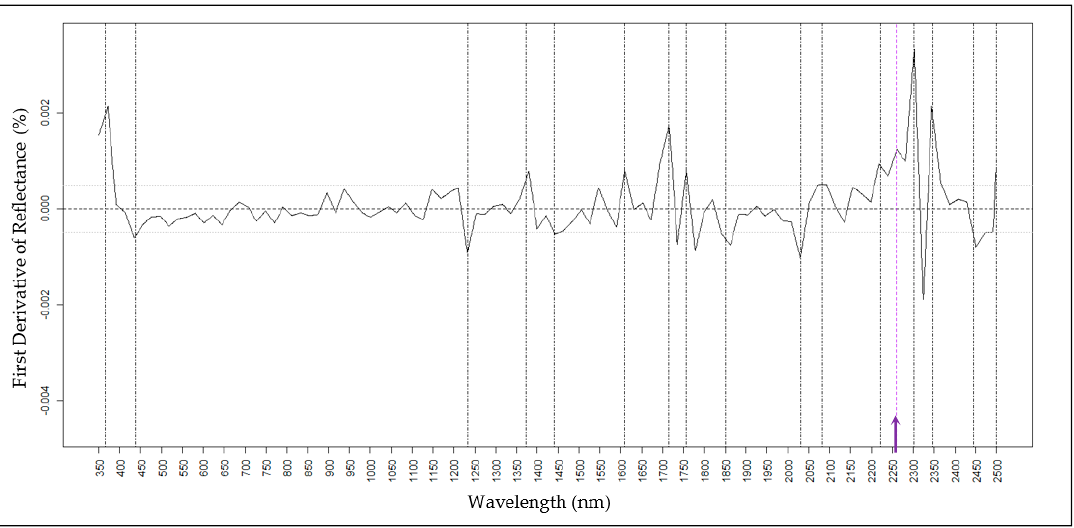
Figure 1. First derivative reflectance of pure Hentriacontanone-16. Black vertical lines indicate the absorption features associated with H16. Purple dash line with an arrow on the base indicates a unique absorption feature for H16.